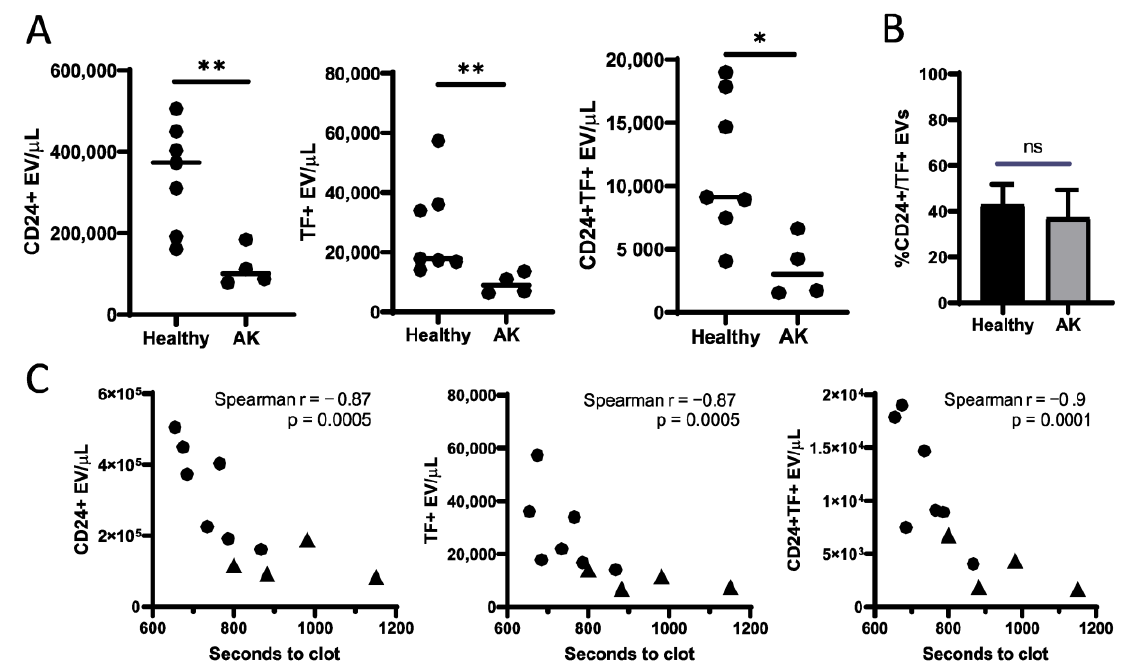
Figure 2. EV enumeration results measured by flow cytometry. ( A ) Differences for CD24+, TF+, and CD24+ TF + EV are reported as EV/uL. ( B ) Differences in ratio of CD24-positive TF+ EVs in individual samples (Healthy n = 7, AK n = 4; mean ± SD). * p < 0.05, ** p < 0.005, ns = not significant; Mann–Whitney test. ( C ) Spearman correlations between individual AF samples. CD24+, TF+, and CD24+ TF+ EV counts against AF clotting onset time. AK = abnormal karyotype. Filled circles